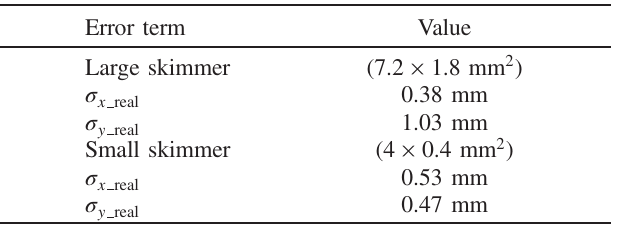
TABLE II. Summary of the beam profile measurements for both large and small